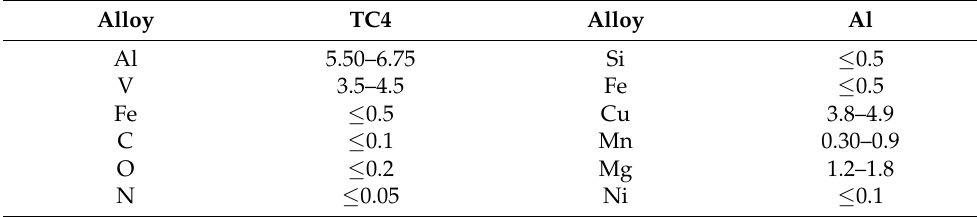
Table 1. TC4 and Al alloy composition (mass fraction)